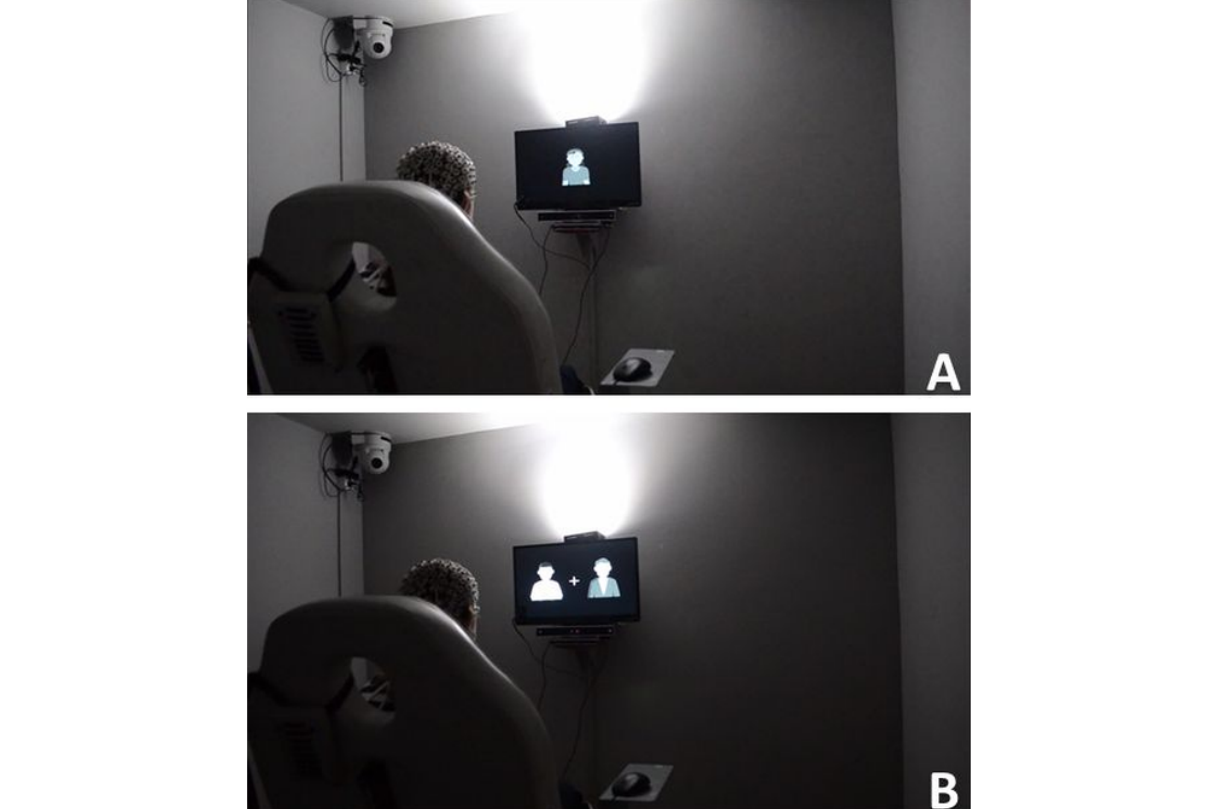
Figure 3. Electroencephalogram (EEG) study protocol. (A) Patient undergoes EEG while passively viewing single virtual agents. (B) Patient undergoes EEG while passively viewing combinations of virtual